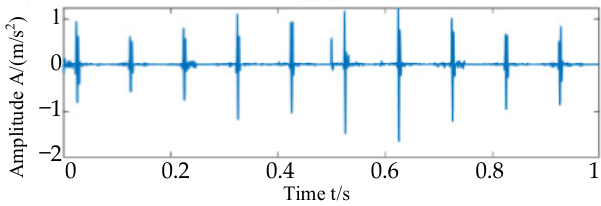
Figure 12. Time-domain waveform of reconstructed signal.